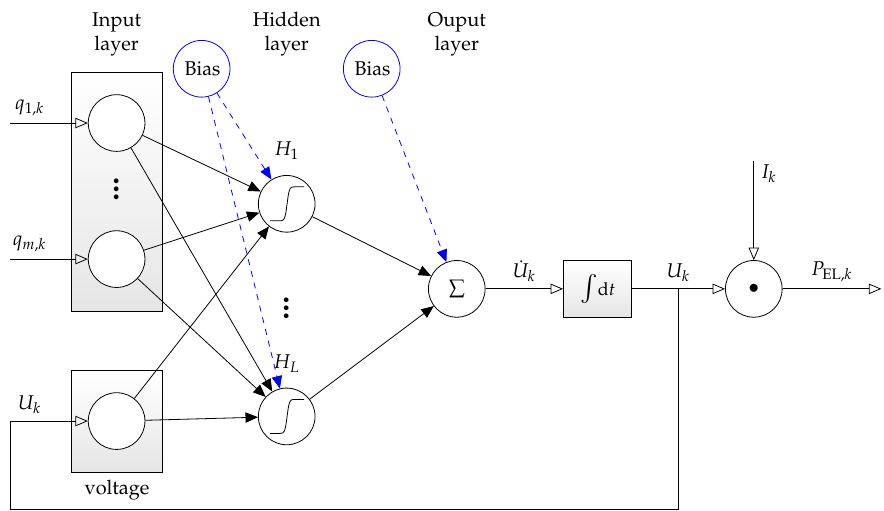
Figure 5. Dynamic neural network model for the electric power characteristic of the SOFC stack with the network inputs ϑ m, ( 1,1,1 ) , k , ϑ m, ( 1,3,1 ) , k , I k , ϑ CG,m, k , ˙ m N